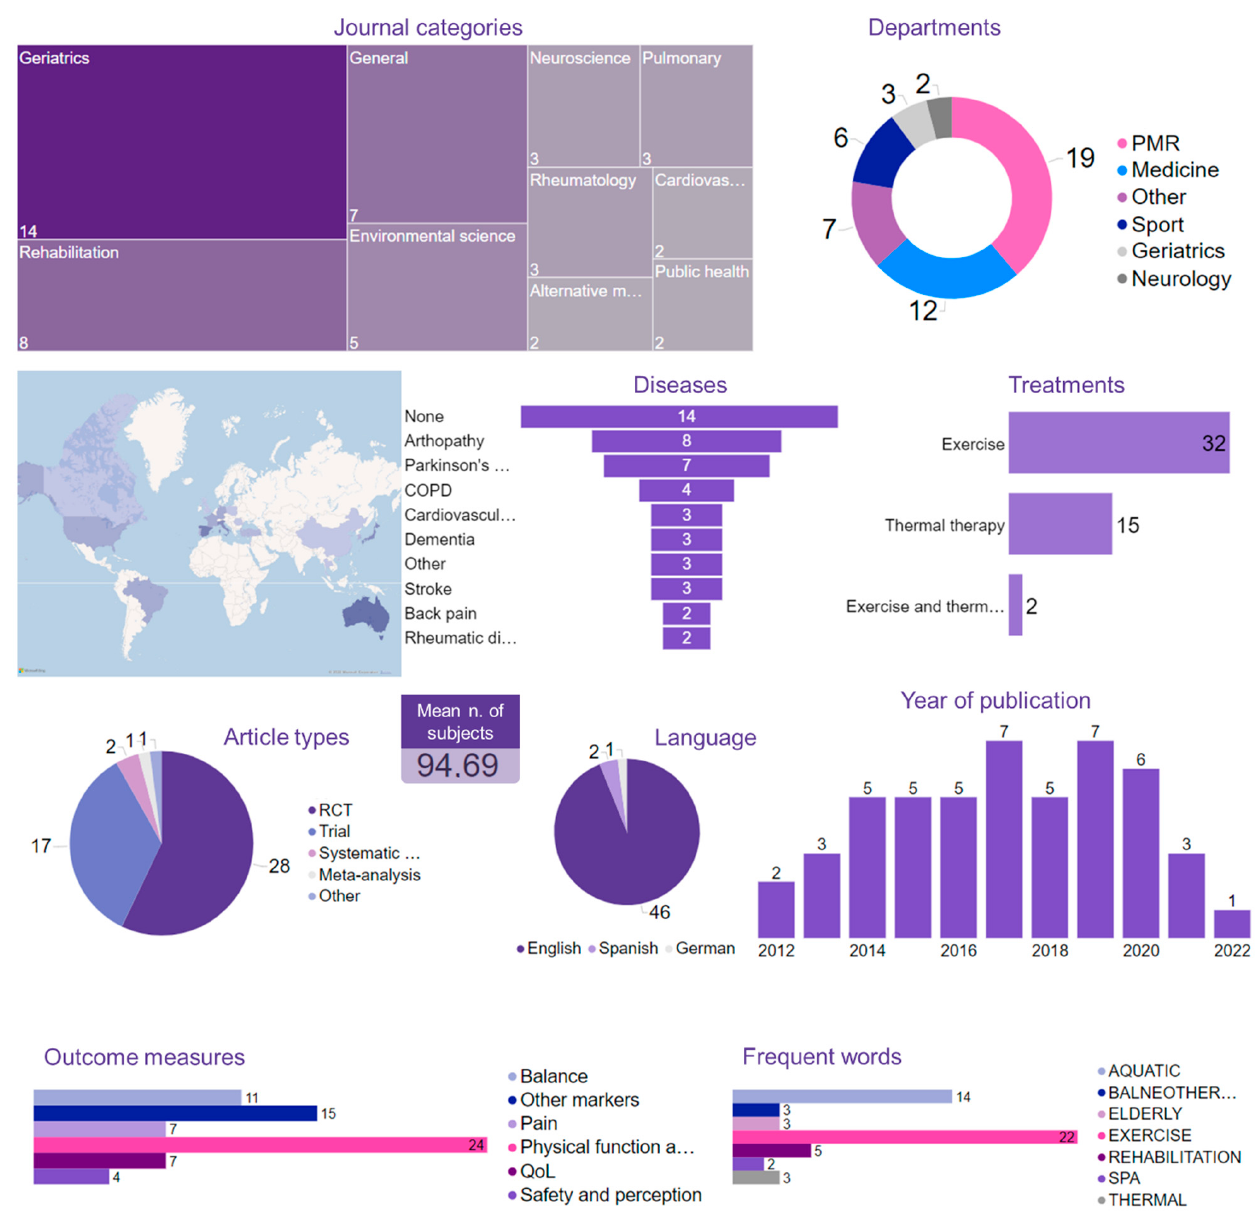
Figure 3. General results. From upper left: journal categories, departments, geographical distribution, main diseases, water treatments, types of articles, mean subjects, language of publication, year, outcome measures; most common words in abstracts.